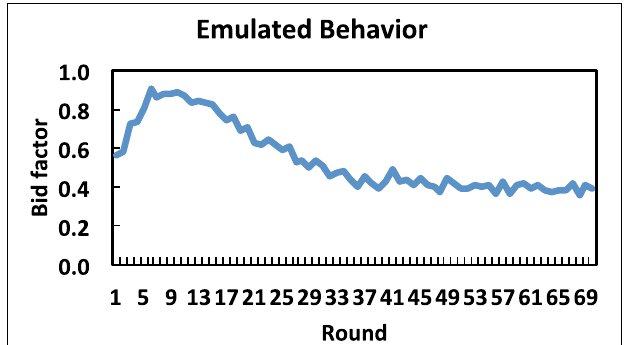
FIGURE A1 | Average bid factor of 35 participants that participated in a pilot study with a 5-player auction with real players. For each computer player a bid factor was picked from a Gaussian distribution of 0.2 around the average bid factor.